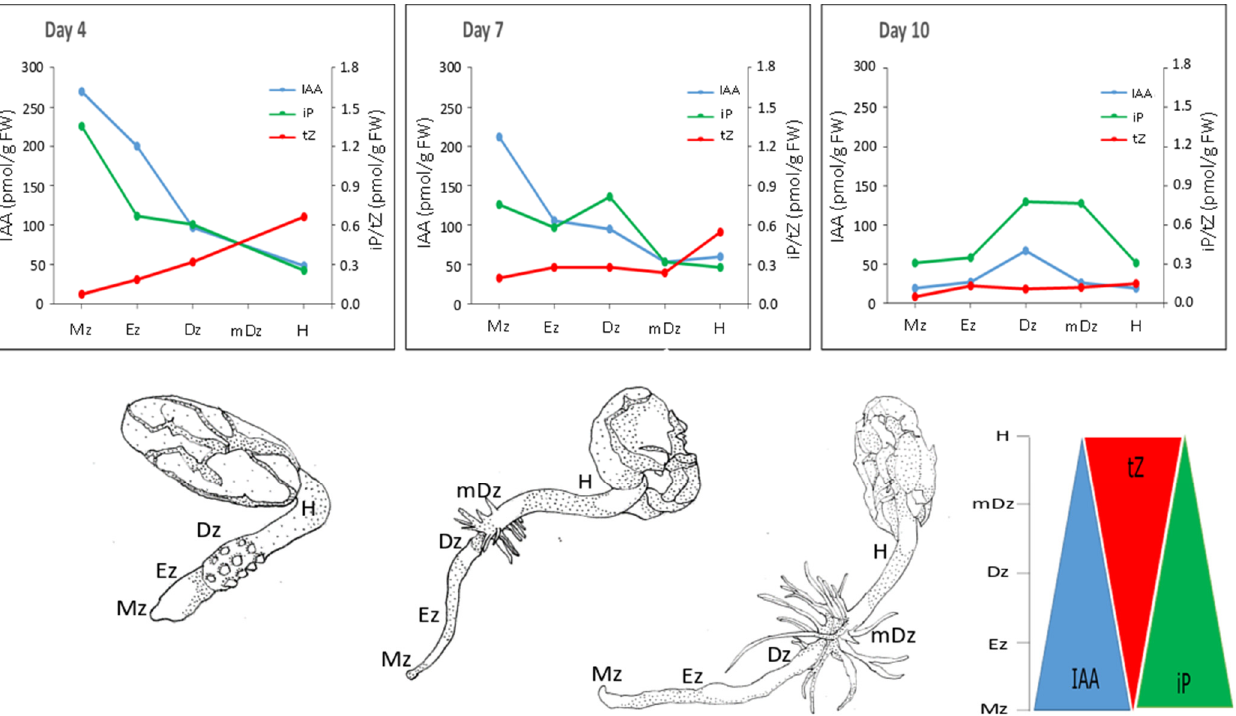
Figure 8. Summary of the dynamic changes in the contents of IAA, tZ, and iP in root developmental zones and hypocotyls during early cacao seedling growth (from 4, 7, and 10 DAI).